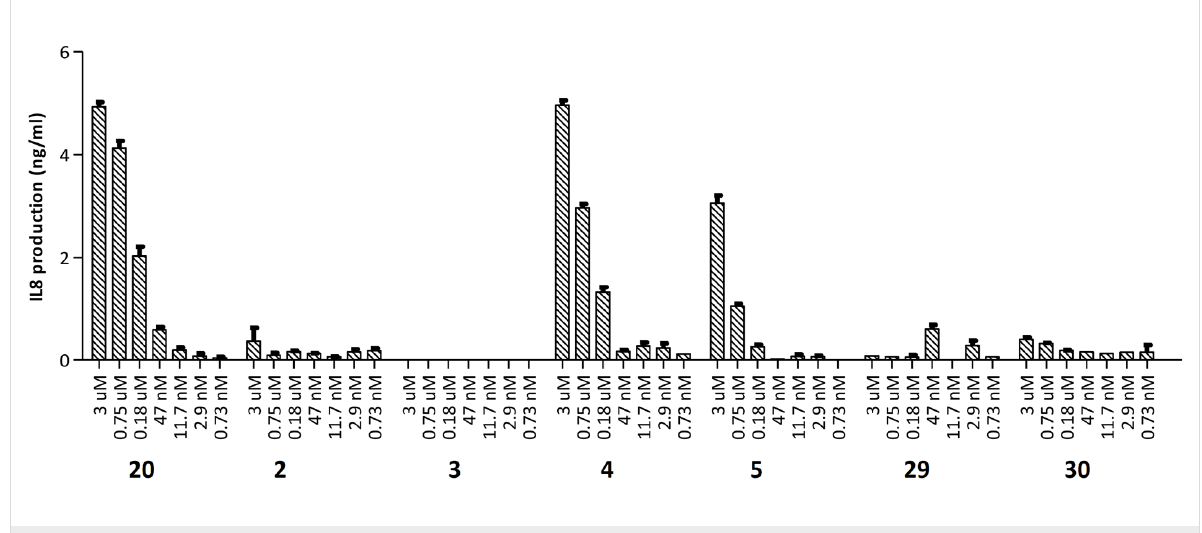
Figure 2: Potency of the NOD2-L antigen conjugates 2 – 5 in NOD2 transfected HEK cells.